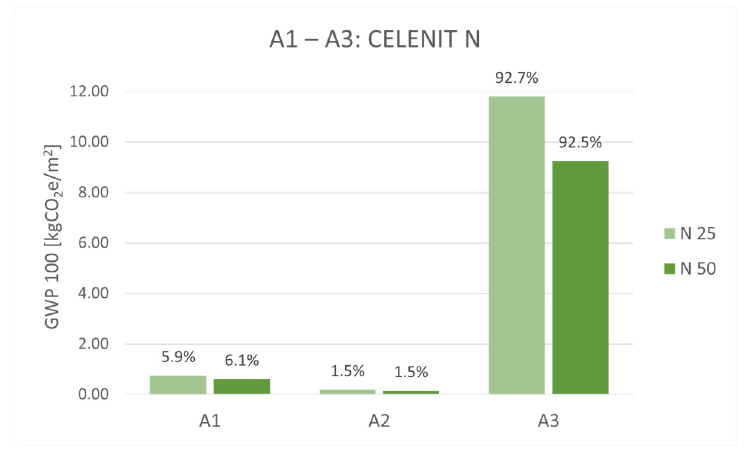
Figure 14. LCIA results for CELENIT N (25 mm and 50 mm).